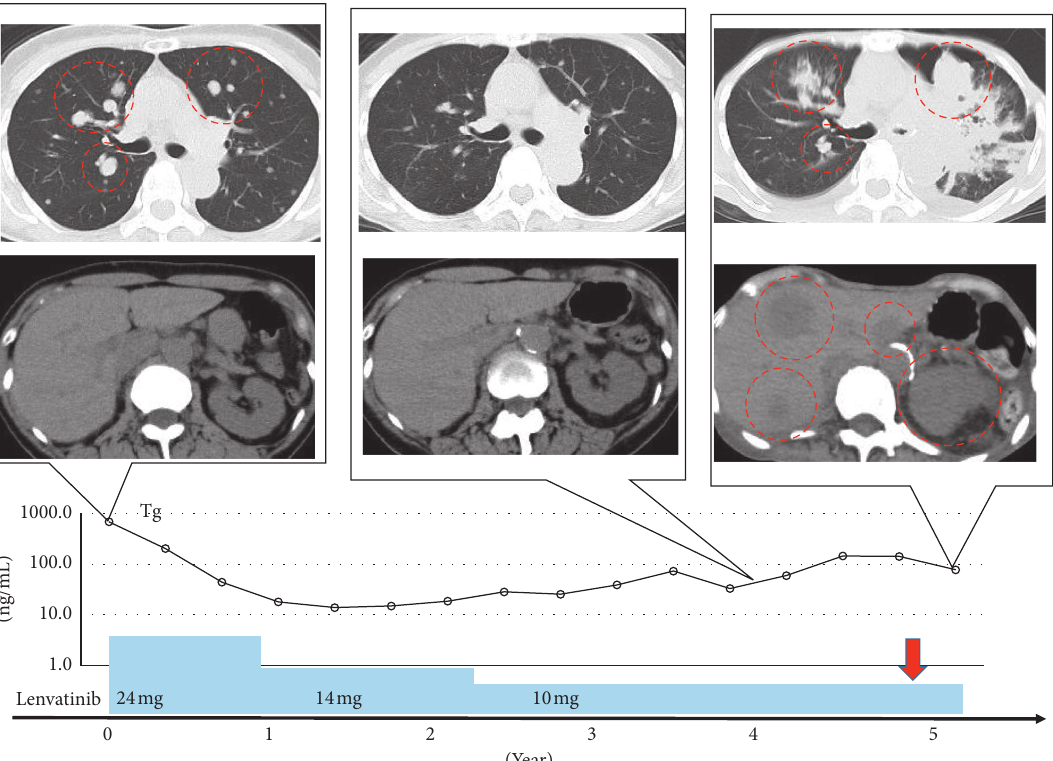
Figure 2: Clinical course of Case 2. The upper image is a chest computed tomography (CT) image. The patient was classified as partial response after treatment with lenvatinib, but then was reclassified as progressive disease after anaplastic transformation and became left atelectasis. The lower image is a CTimage of the upper abdomen, and multiple liver metastases and metastases to the left adrenal gland and kidney appeared after anaplastic transformation. The graph below the image shows the transition of thyroglobulin, the timing of lenvatinib treatment and the dose. The red dotted circle indicates the lesion. The red arrow indicates the time of anaplastic